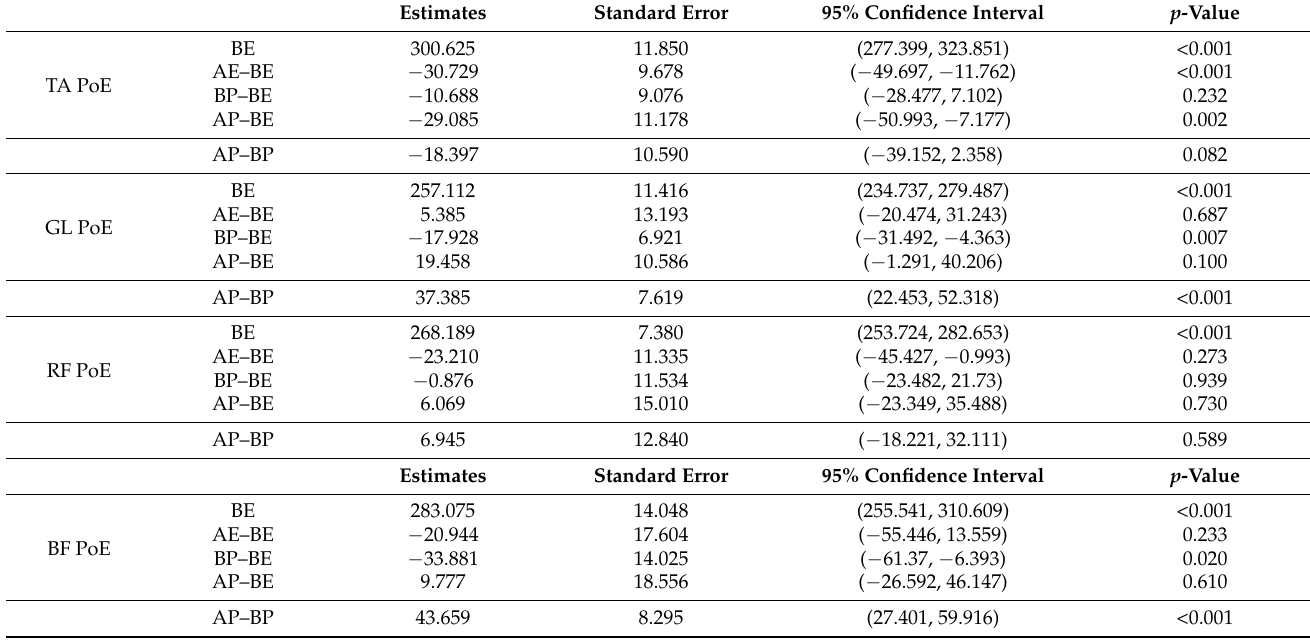
Table 3. Different means of sEMG variables: TA PoE, GL PoE, RF PoE, BF PoE between the pairs of times (AE–BE, BP–BE, AP–BE, and AP–BP). The results obtained by fitting the linear mixed-effect (LME) model for sEMG variables under the Box-Cox